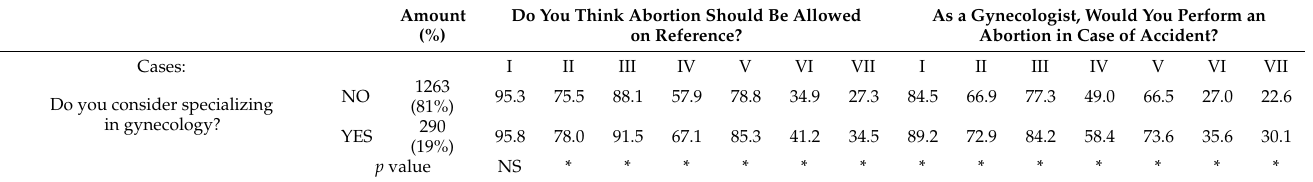
Table 9. Attitude to abortion among medical students considering specialization in gynecology and obstetrics. All data contained in table are presented in percentage [%] of answers YES in each case. Differences between two groups in each case was tested using chi-square